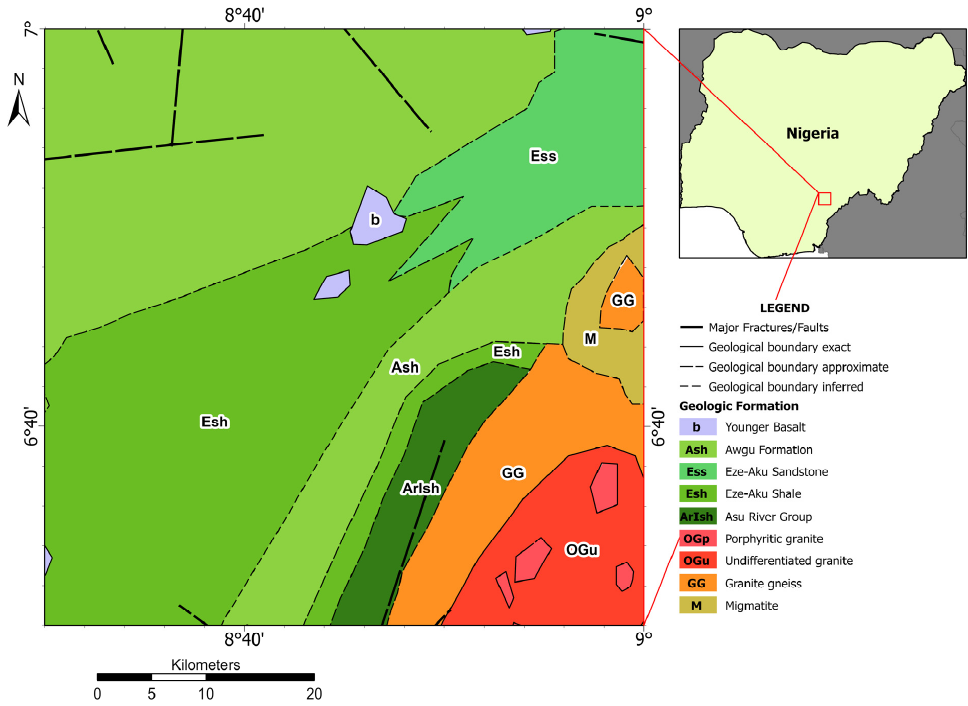
Figure 1. Geologic map of the study area.